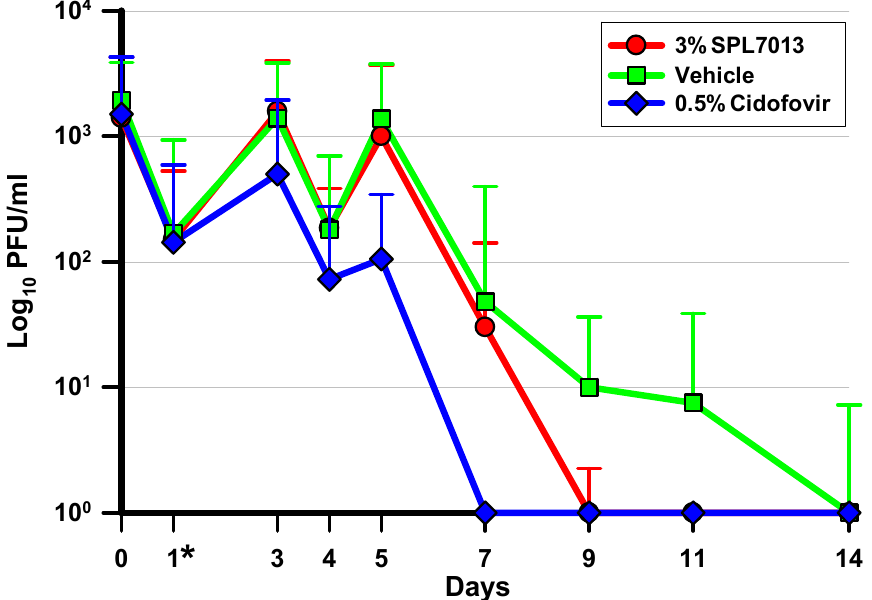
Figure 3. The median and interquartile ranges of ocular HAdV5 titers over the course of the antiviral efficacy study. Significant differences were demonstrated on days 5 and 7 (0.5% Cidofovir < 3% SPL7013 = vehicle) and on days 9, 11, and 14 (0.5% Cidofovir = 3% SPL7013 < Vehicle) ( p ≤ 0.0001, Kruskal–Wallis ANOVA). <, significantly less than; =, statistically indistinguishable; *, indicates that treatment was initiated on day